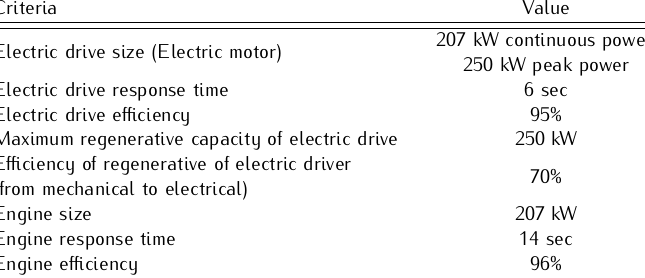
Table 4. PHEV transit bus model